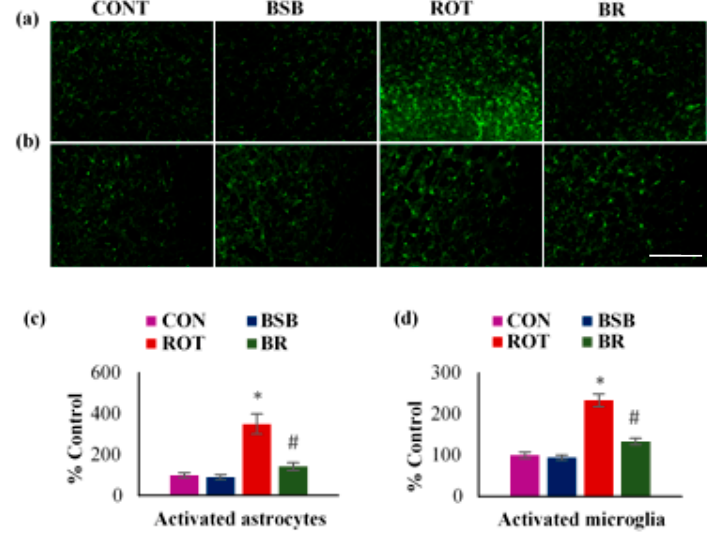
Figure 5. The immunofluorescence expression of GFAP and Iba-1 in striatum was determined. A profound expression of GFAP-positive astrocytes ( a ), and Iba-1-positive microglia ( b ), was observed in the ROT-injected rats in comparison with vehicle treated control (CON) rats. Interestingly, BSB treatment to ROT injected rats showed decreased expression of GFAP and Iba-1 compared to ROT injected rats (scale bar = 200 µ m). The quantitative representation of the result of activated astrocytes and microglia in the striatum is shown ( c , d ). Each group contained three rats and the data were expressed as percent mean ± SEM. * p < 0.05 CON vs ROT; # p < 0.05 ROT vs. BR (One-way ANOVA followed by Tukey’s test).